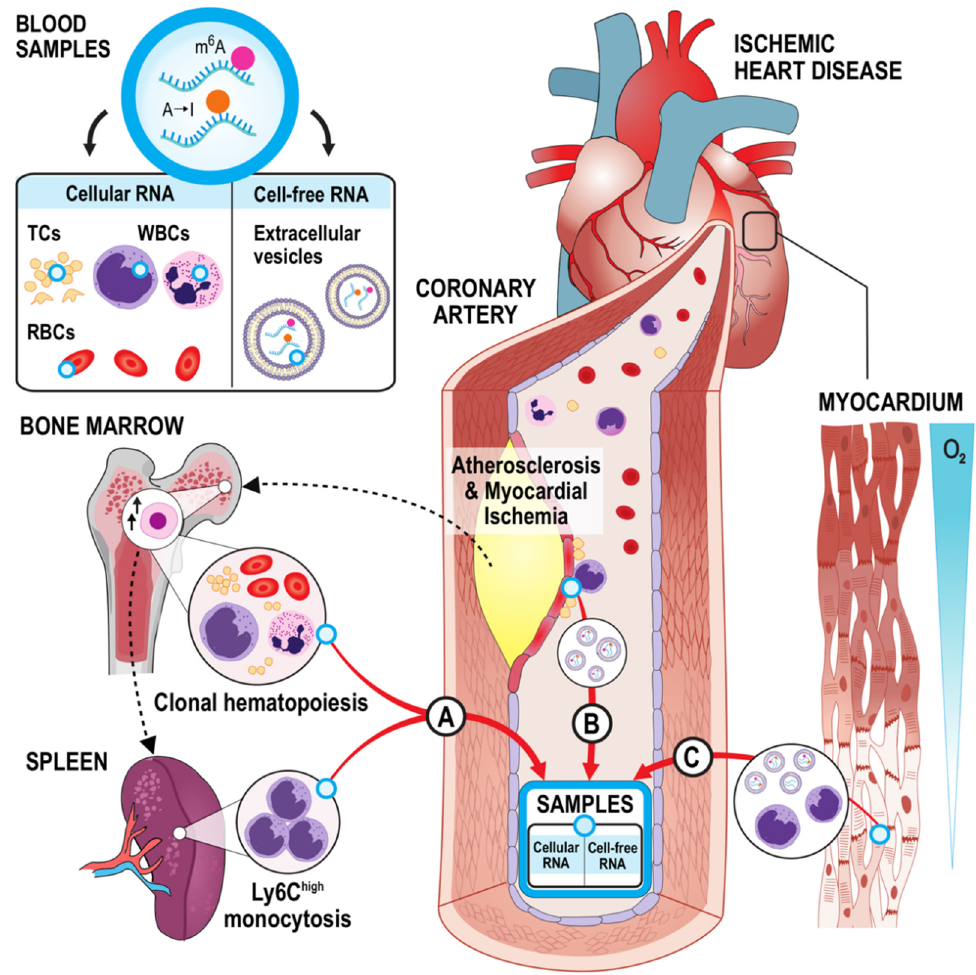
Figure 2. IHD-EPITRAN hypotheses ( A ). Coronary plaques signal bone marrow residing HSCs to increase proliferation promoting the efflorescence of CH and extramedullary hematopoiesis (Ly-6C high monocytosis), which both seed epitranscriptomically distinct cells to the circulation. ( B ). Leukocytes and platelets patrolling in the proximity and inside the atherosclerotic plaques, ischemic myocardium, and stressed endothelium oscillate back and seed EVs to the circulation with detectable alterations in their m 6 A and A-to-I RNA signatures. ( C ). The ischemic myocardium prime patrolling leukocytes and secrete paracrine EVs encasing m 6 A and A-to-I modified RNA molecules, entering also to the circulation. A-to-I , adenosine-to-inosine; CH , clonal hematopoiesis; EV , extracellular vesicle; HSC , hematopoietic stem cell; Ly6C , lymphocyte antigen 6; m 6 A , N 6 -methyladenosine; RBCs , red blood cells; TCs , thrombocytes; WBCs , white blood cells. Table 1. Main goals of the IHD-EPITRAN study with brief respective descriptions. IHD , Ischemic heart disease. Goal Description